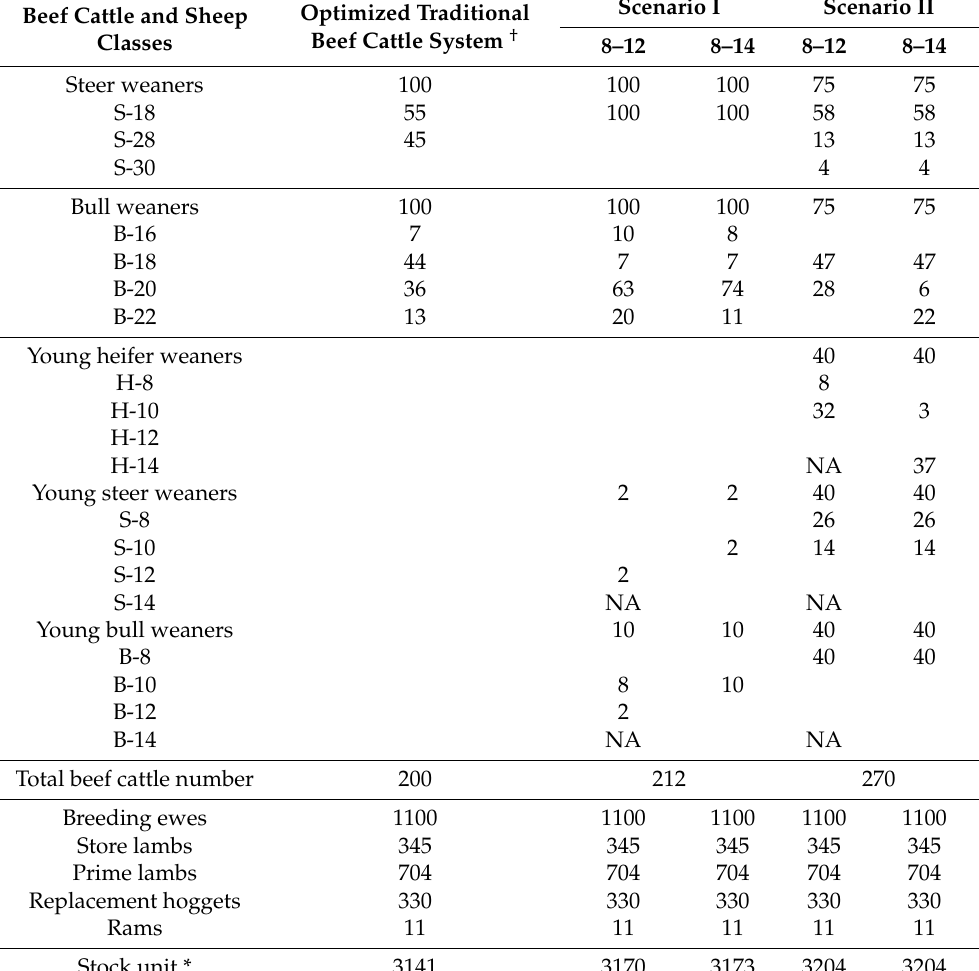
Table 3. The number of weaner steers and bulls, finished steers (S-18, S-28, S-30) and bulls (B-16, B-18, B-20 and B-22) (sold for meat processing), young heifers, steers and bulls finished at 8, 10, 12 and 14 months of age and breeding ewes and rams, prime lambs (sold for meat processing) and store lambs (sold to other farmers for finishing) and prime and replacement hoggets (between 4 to 16 months of age, mated at 8 months of age) and their equivalent stock units in the optimized beef cattle system, Scenario I and Scenario